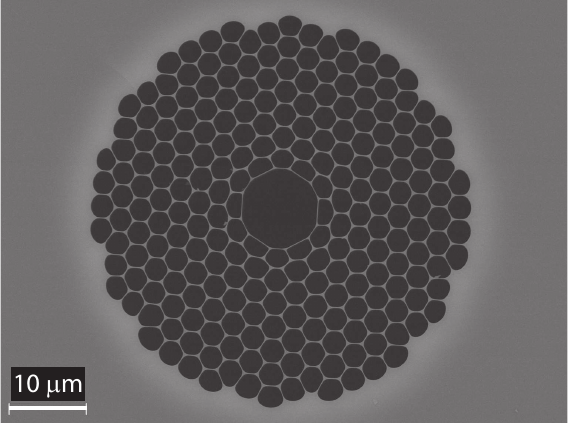
Figure 2. SEM image of the cross-section of the HC-PBF used in the experiments.